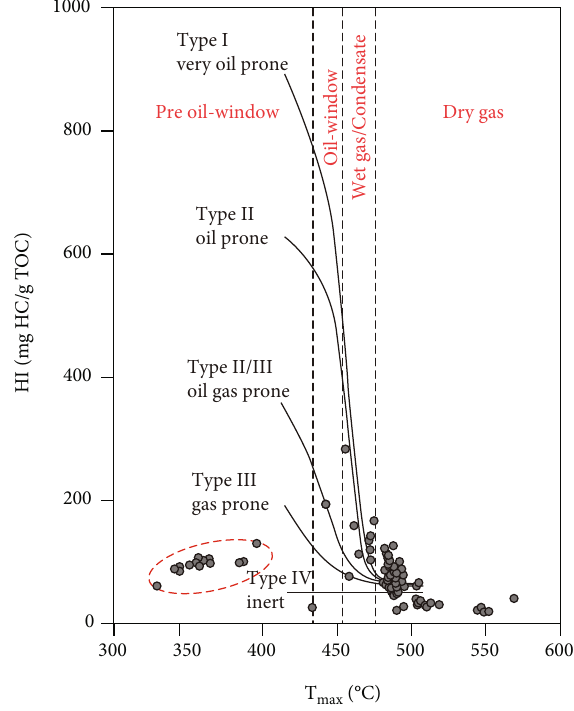
Figure 4: Plot of TOC (wt.%) vs. HI (mgHC/gTOC) of the K (according to